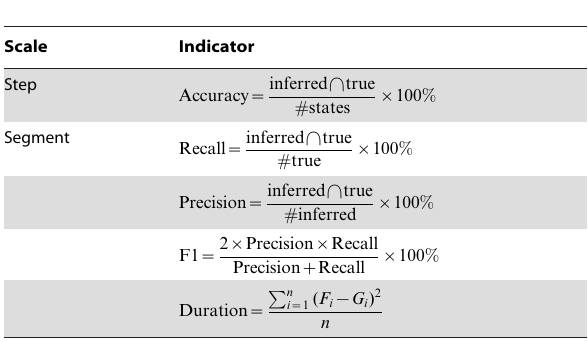
Table 1. Indicators of model performance.